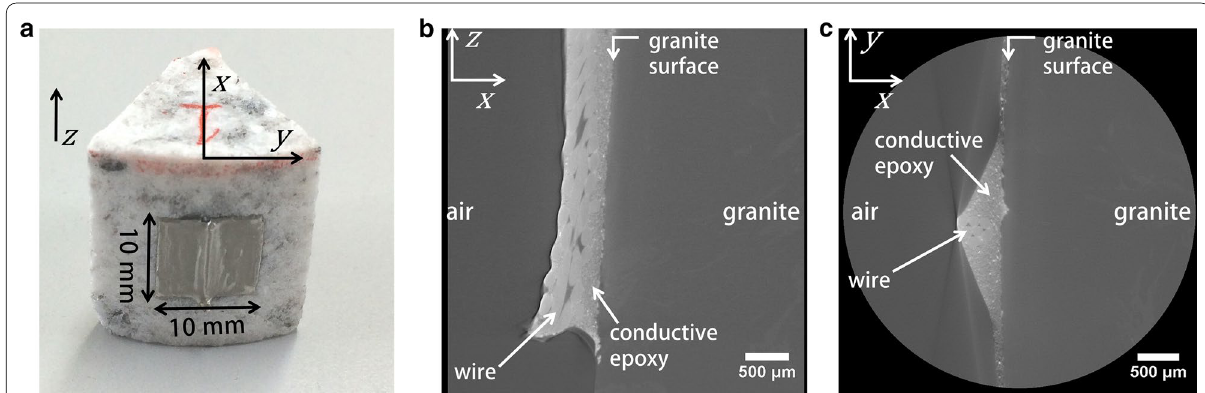
Fig. 5 Microstructures of the contact surface observed by micro-focus X-ray computed tomography (CT). a Sample photograph showing the 100 mm 2 electrode. CT images of the b x–z and c x–y planes; the pixel size is approximately 4 μm, and the scale bar in each image is 500 μm. Black in the CT images represents areas of X-ray transmission; the white areas are opaque to X-rays. Here, black represents mainly air, dark grey is mainly granite, and light grey is the conductive epoxy adhesive and